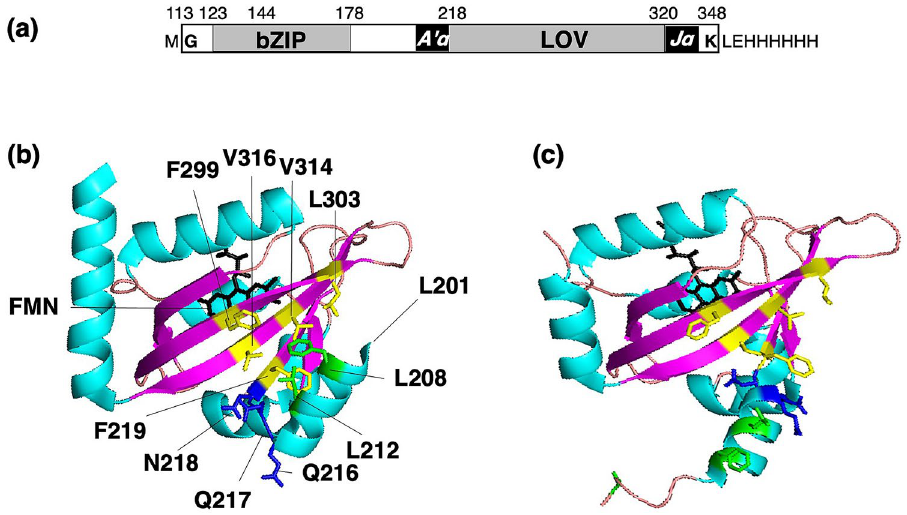
Figure 1. ( a ) The domain structure of PZ. Amino acids replaced in this study are indicated in the crystal structures of the Pt AUREO1a-LOV in the ( b ) dark and ( c ) light states (PDB: 5DKK and 5DKL). Amino acids in the β -sheet region, hinge region, and A’ α helix are shown in yellow, blue, and green,